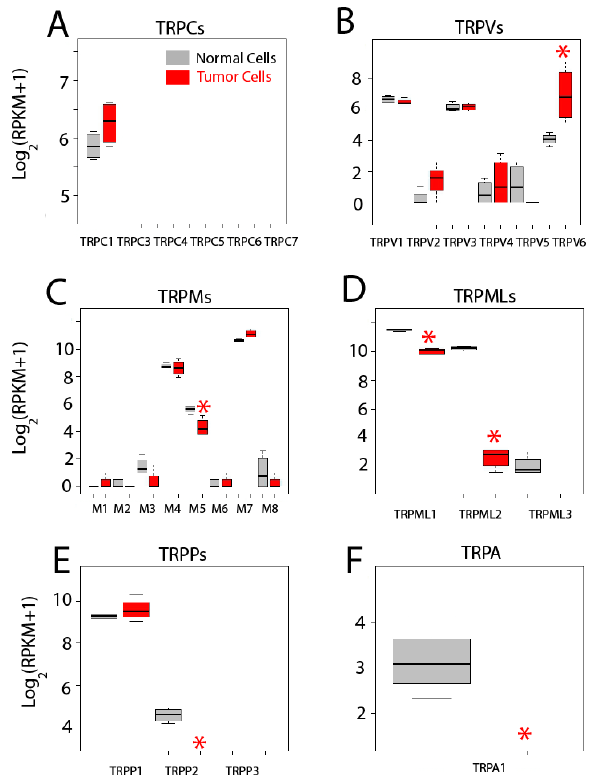
Figure 9. Expression of transient receptor potential (TRP) channels in normal and colon cancer cells. Expression levels of canonical transient receptor potential channels TRPCs ( A ), canonical Transient Receptor Potential channels (TRPVs ) ( B ), Melastatin Transient Receptor Potential channels ( TRPMs ) ( C ), Mucolipin Transient Receptor Potential channels ( TRPMLs ) ( D ), Polycystin Transient Receptor Potential channels ( TRPPs ) ( E ) and Transient Receptor Potential channel member A, subfamily 1 (TRPA1 ) ( F ) in normal colonic cells (grey bars) and colon cancer cells (red bars). * p statistically significant by three independent methods.